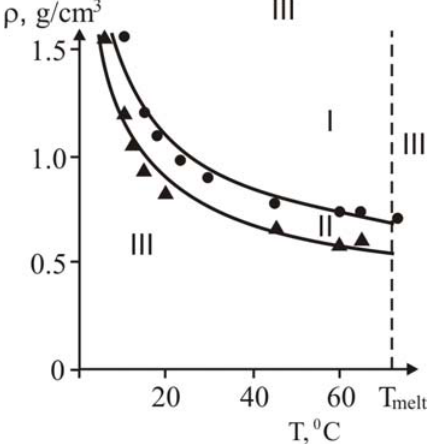
Figure 18. Density-temperature diagram for three regimes of frontal polymerization [28].